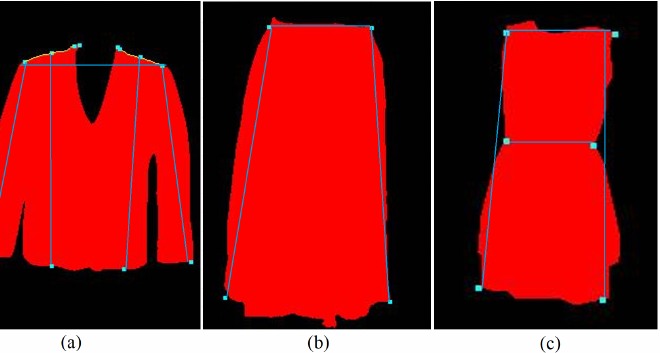
Figure 6. The instances of measurements predicted key points for different types of garments: ( a ) blazer, ( b ) skirt and ( c )